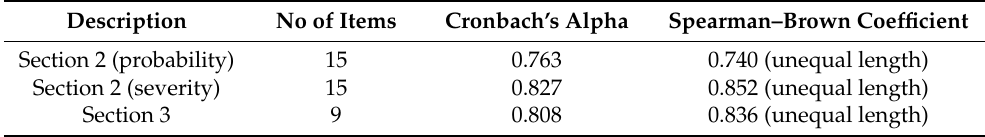
Table 3. Summary of SPSS output results obtained for Cronbach’s alpha and Spearman–Brown Coefficient.